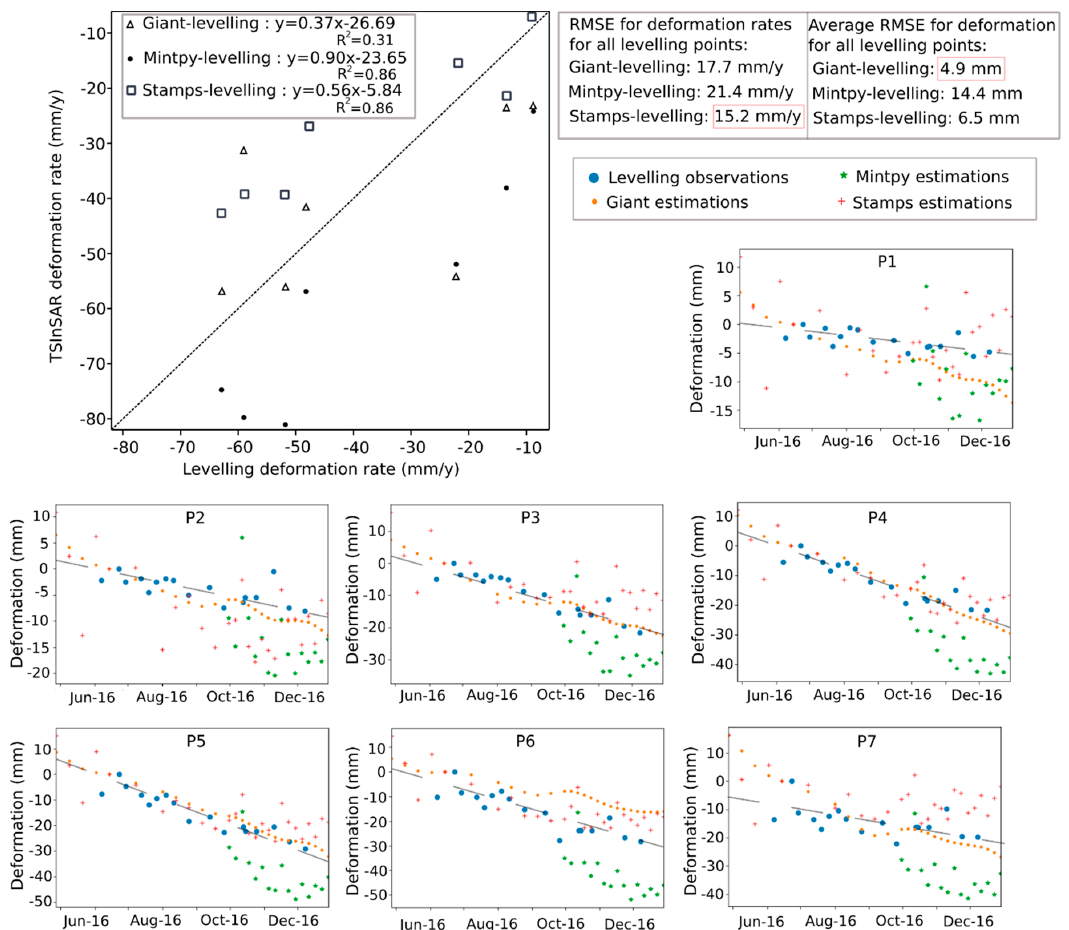
Figure 6. Comparison of TSInSAR accumulated displacement (subsidence) results with in-situ measurements for seven leveling points (position of the leveling point given in Figure 2). Leveling values are projected in the LOS direction for the comparison.